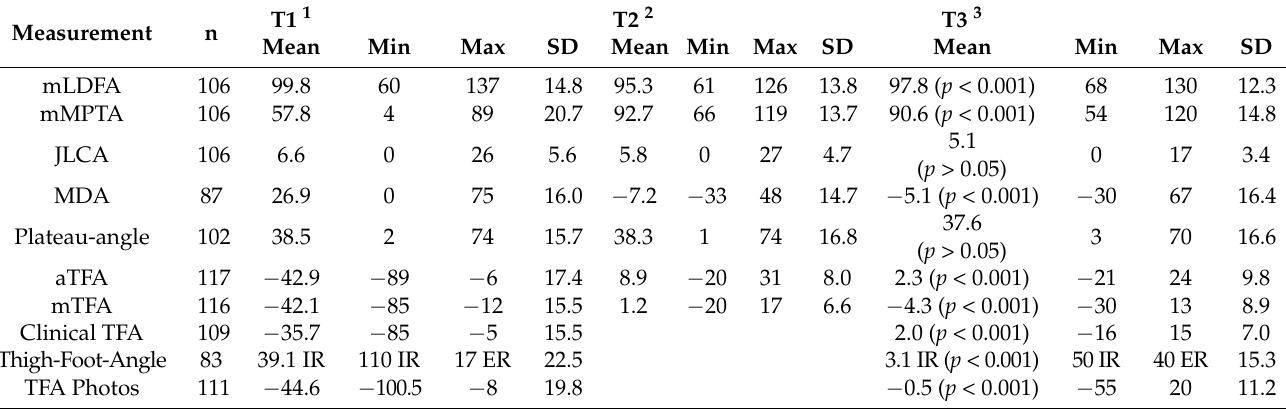
Table 1. Results of radiographic, clinical and photographic measurements. N states the number of patients with completed measurements. T1 refers to the preoperative measurements. T2 refers to the measurements taken directly postoperative in a cast. T3 refers to the measurements taken at